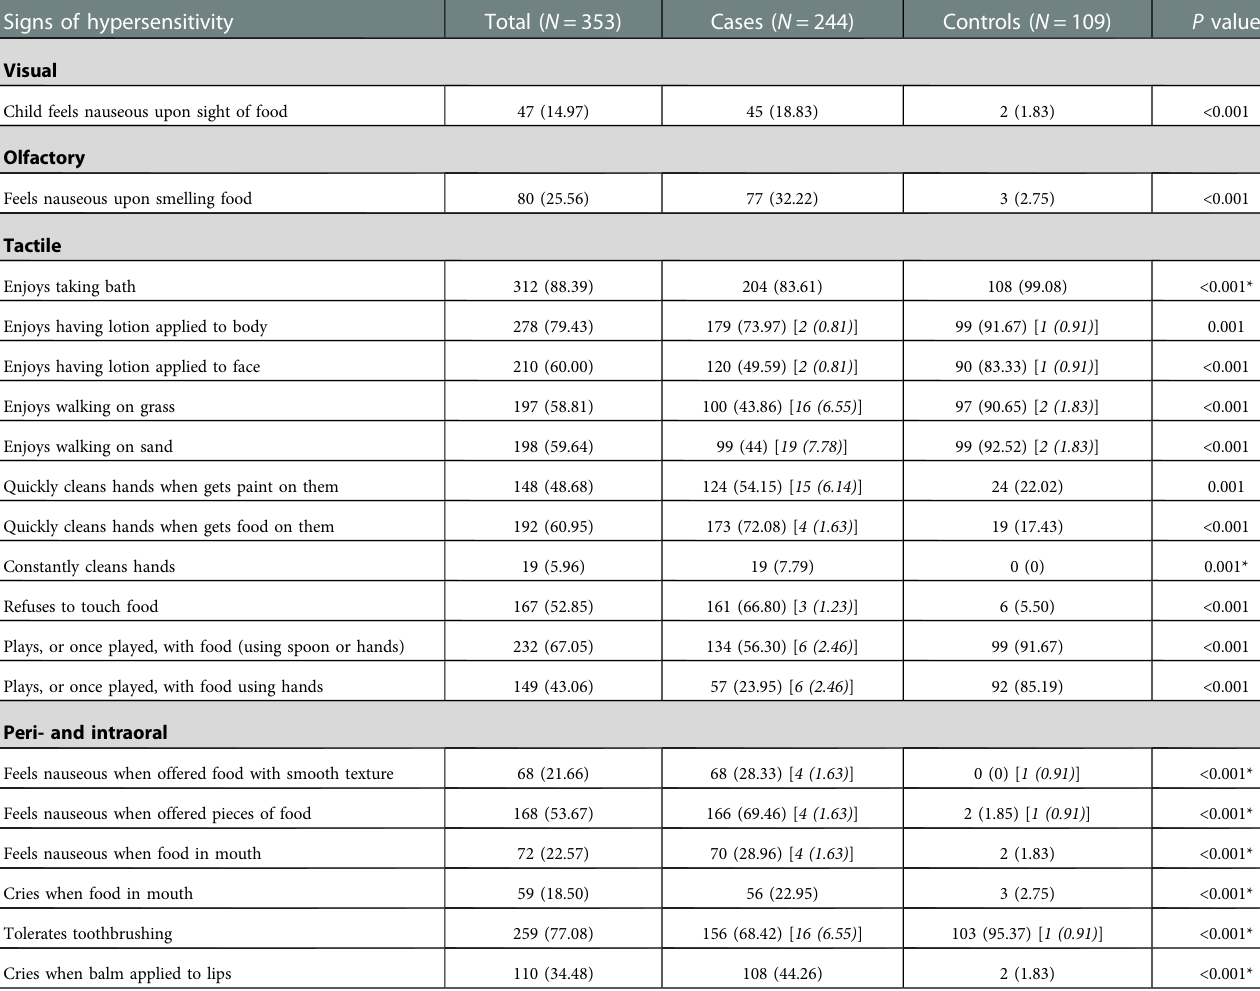
TABLE 3 Signs suggestive of sensory hypersensitivity. Data represents number (%) of patients with stated characteristics. Where there are missing data, the number (%) of children concerned is indicated in italics and brackets.